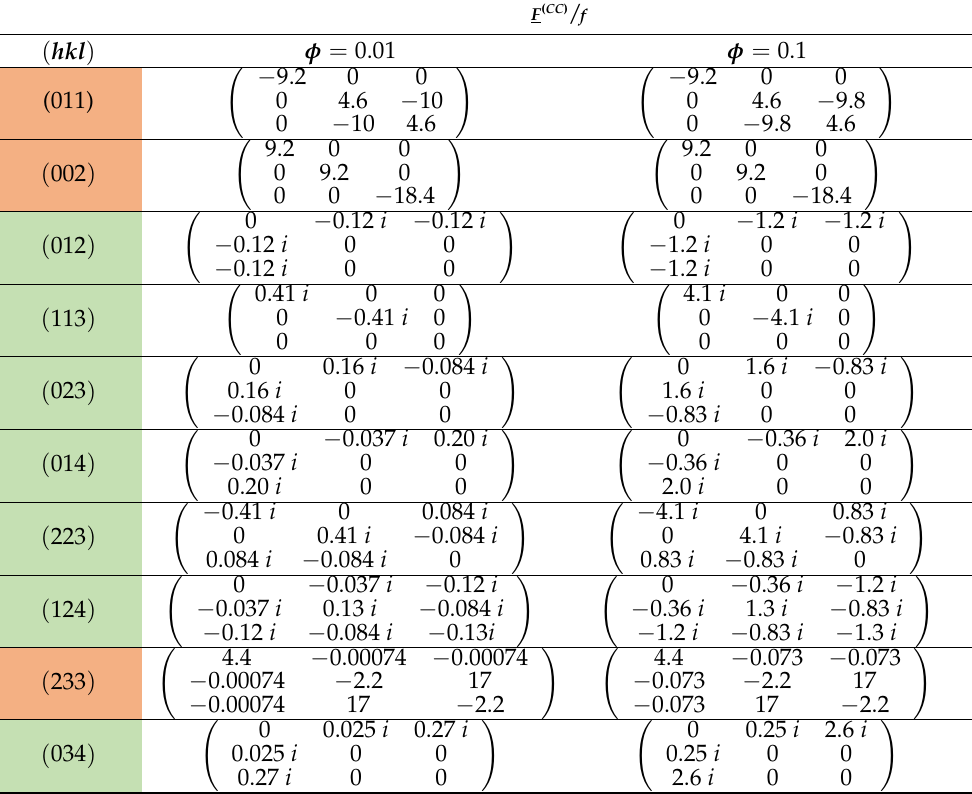
Table 3. Miller indices ( hkl ) of the resonant (green) and resonantly enhanced (orange) peaks predicted by the model and the corresponding tensor form factor ( F ( CC ) ) in units of the tensor element ( f ), for two inclinations of the polarization axis of scatterers ( φ ). Only those resonantly enhanced peaks are included that are not observed in the nonresonant X-ray